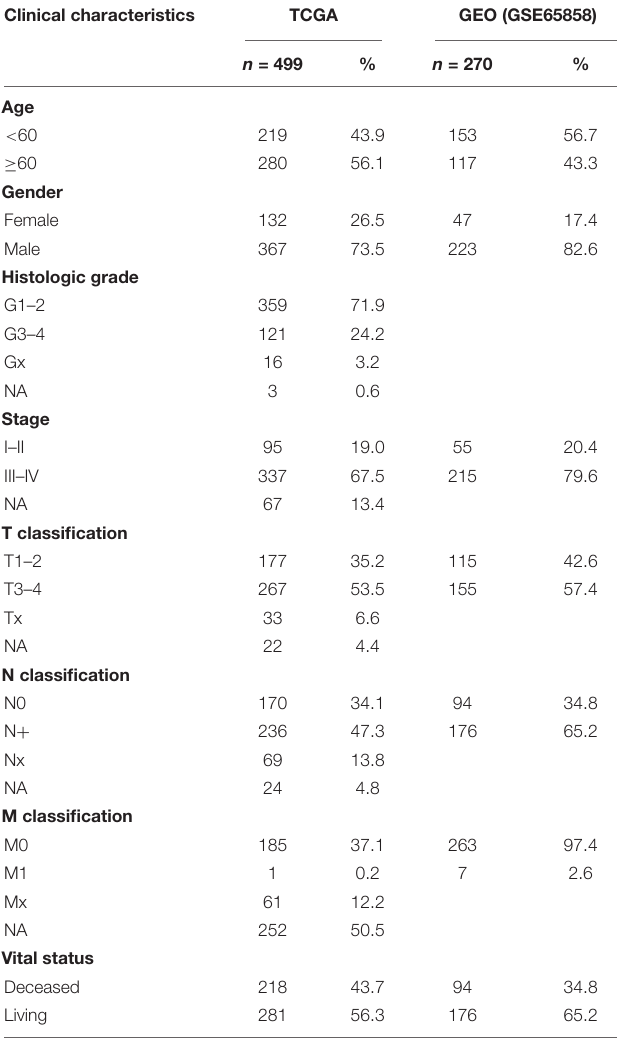
TABLE 1 | Clinical characteristics of SCCHN patients in TCGA and GEO data sets. Clinical